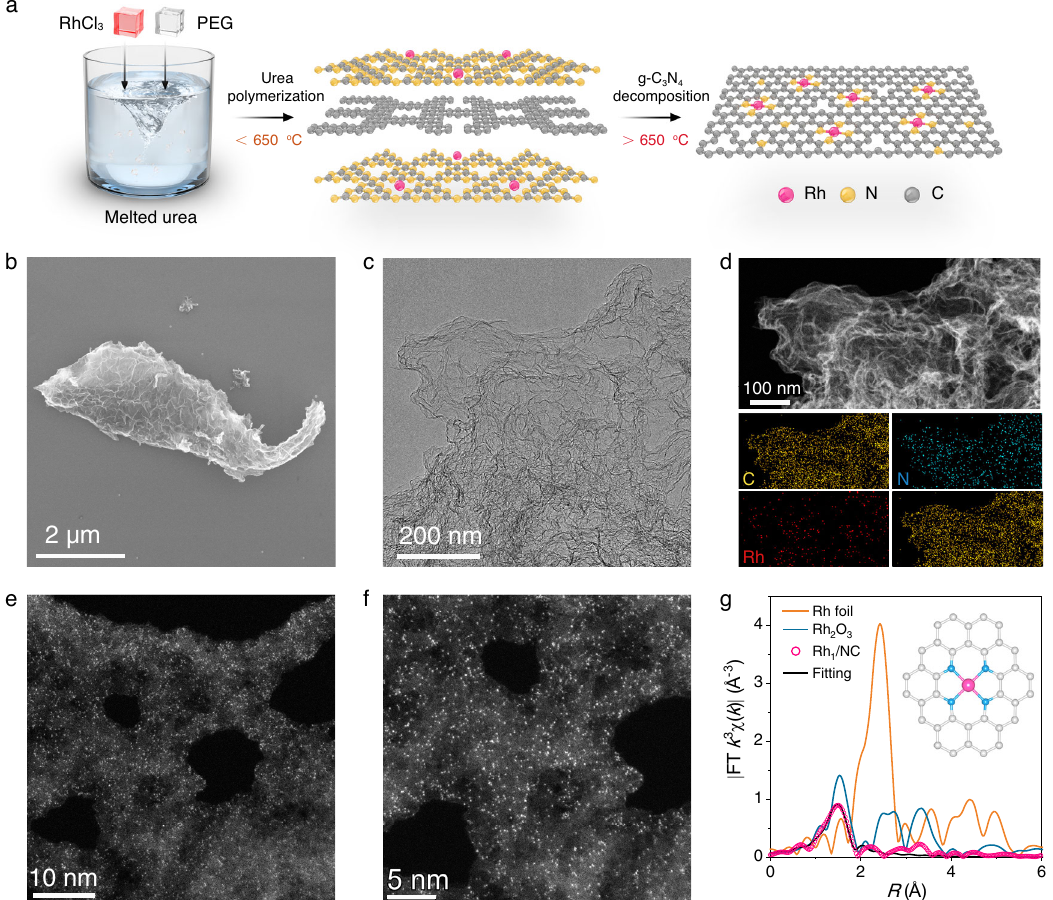
Fig. 1 Synthesis and characterization of Rh 1 /NC. a Schematic of the synthesis process of Rh 1 /NC. TEM b and SEM c images of Rh 1 /NC. d HAADF-STEM image and the corresponding energy-dispersive X-ray elemental mapping of Rh 1 /NC. e , f Atomic-resolution HAADF-STEM images of Rh 1 /NC. g FT-EXAFS spectra at the Rh K-edges of Rh 1 /NC Rh foil and Rh 2 O 3 . Insert: structure of RhN 4 for EXAFS fi tting and DFT calculation. Experiment (Fig. 1b – f) was repeated 3 times independently with similar